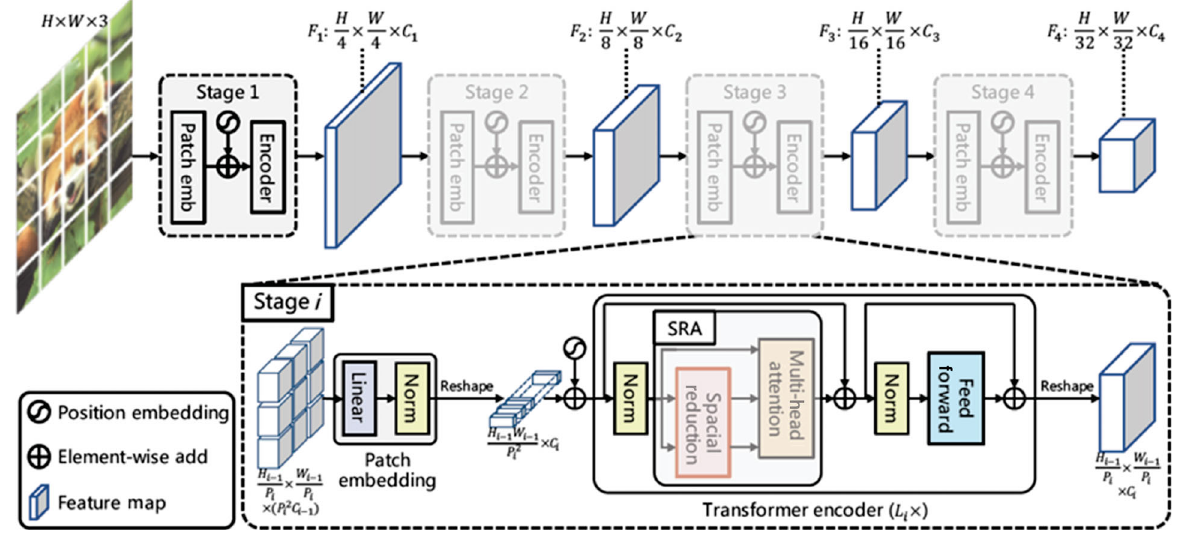
Fig. 12 Framework of PVT. Reproduced with permission from Ref. [27], c (cid:2) The Author(s) 2021.